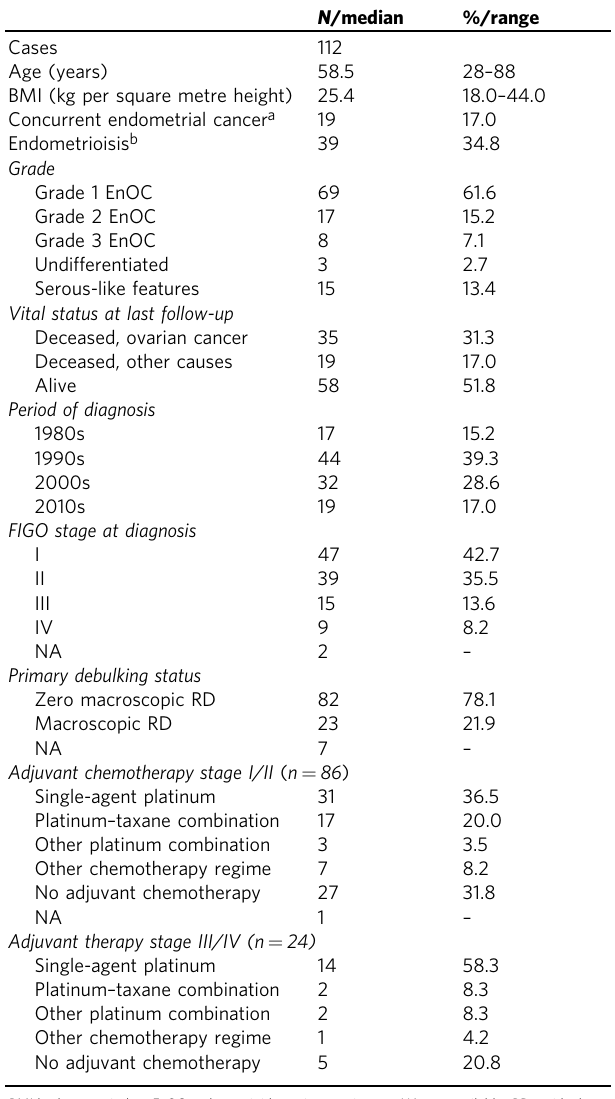
Table 1 Clinical characteristics of the 112 endometrioid ovarian carcinoma cases.